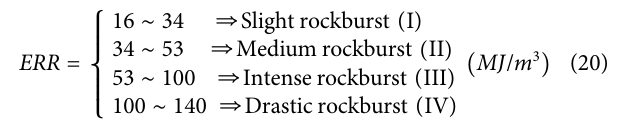
Frontiers in Earth Science |